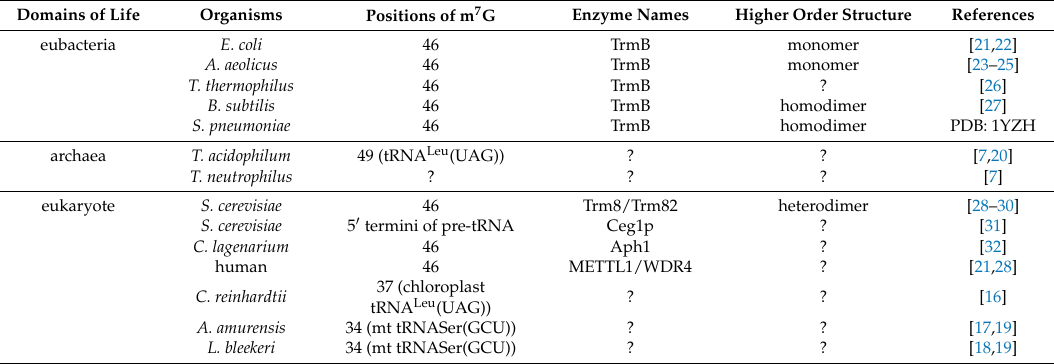
Table 1. N 7-methylguanosine methyltransferase in